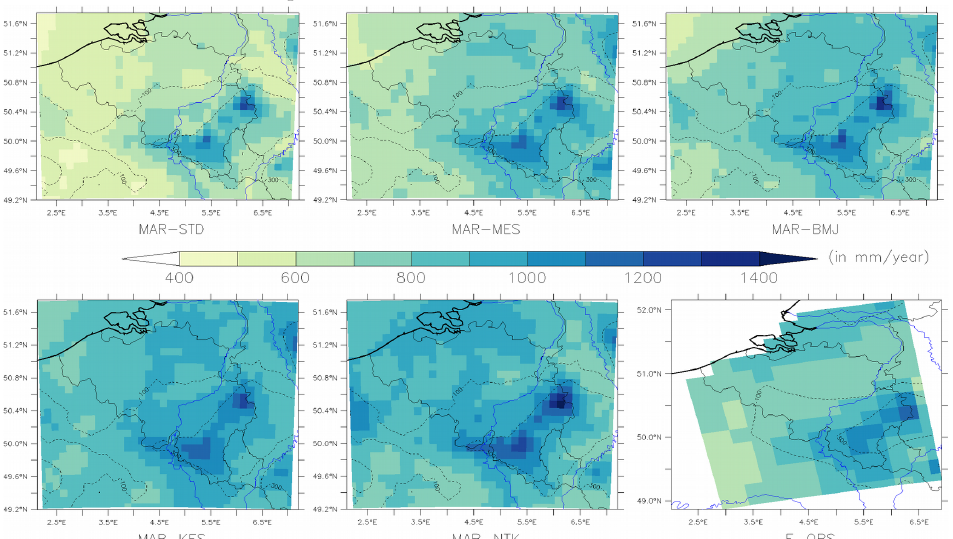
Figure 4. Mean annual precipitation over 1987–2017 simulated by MAR for each experiment and provided by E-OBS in mm/year. Dotted black lines represent the 100 m and 300 m elevation of the MAR (resp. E-OBS) and the blue lines represent the major rivers of our studied area.